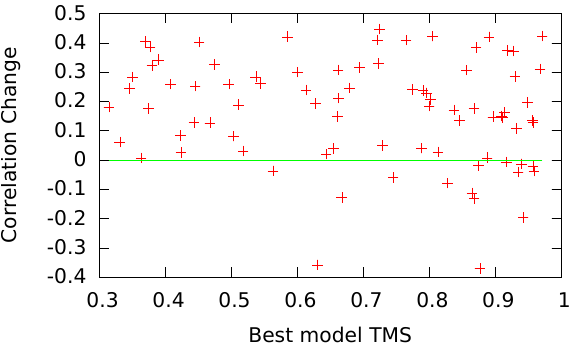
Figure 5. Difference in correlation between OUNRES and UNRES as a function of the TMS to native of the best available decoy for that CASP11 target. Smaller values on the x-axis indicate harder targets, while the y-axis measures the success of UNRES optimization, with higher values indicating greater success.